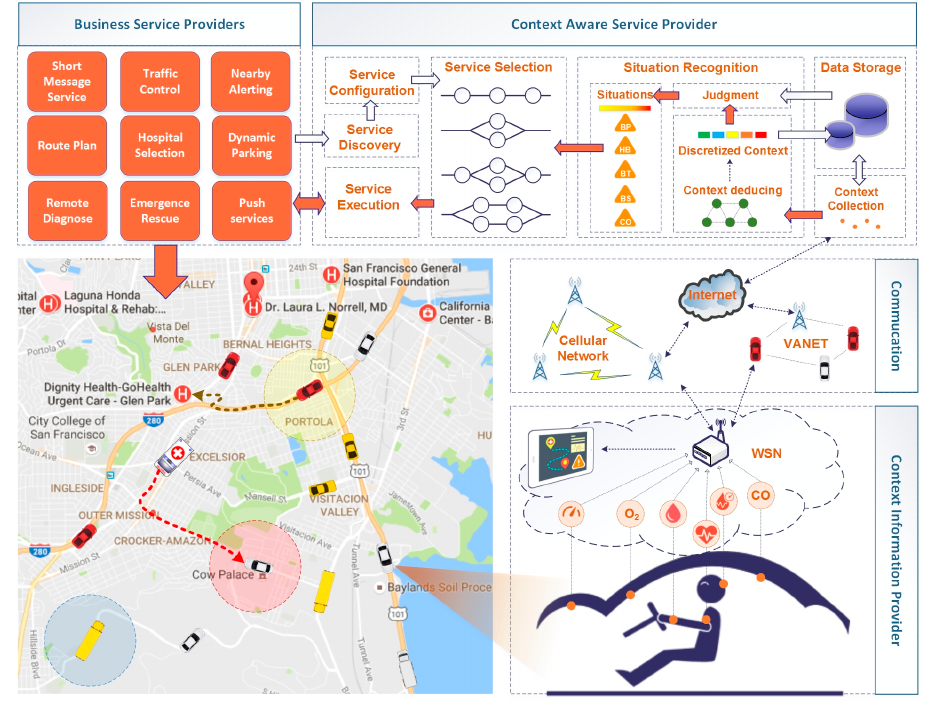
Figure 1. System architecture consists of four main parts Context Information Provider (CIP), Commutation, Context-Aware Service Provider (CASP) and Business Service Provider (BSP).